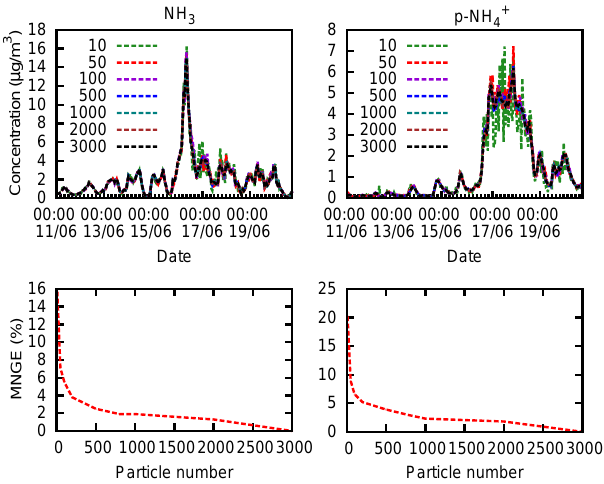
Fig. 2. Sensitivity of the model simulation to the number of parti- cles: modeled NH 3 (left) and p -NH + (right) concentrations (top) at 4 Egbert with different particle numbers; MNGEs (bottom) of NH 3 (left) and p -NH + (right) concentration relative to the simulation 4 with 3000 particles.